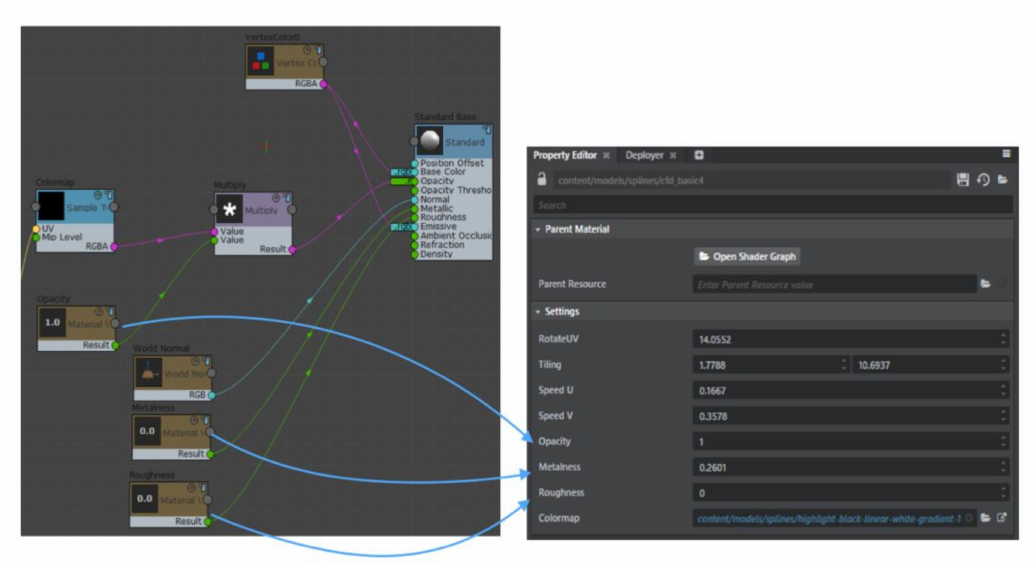
Figure A4. Step 3 in CFD animation material.